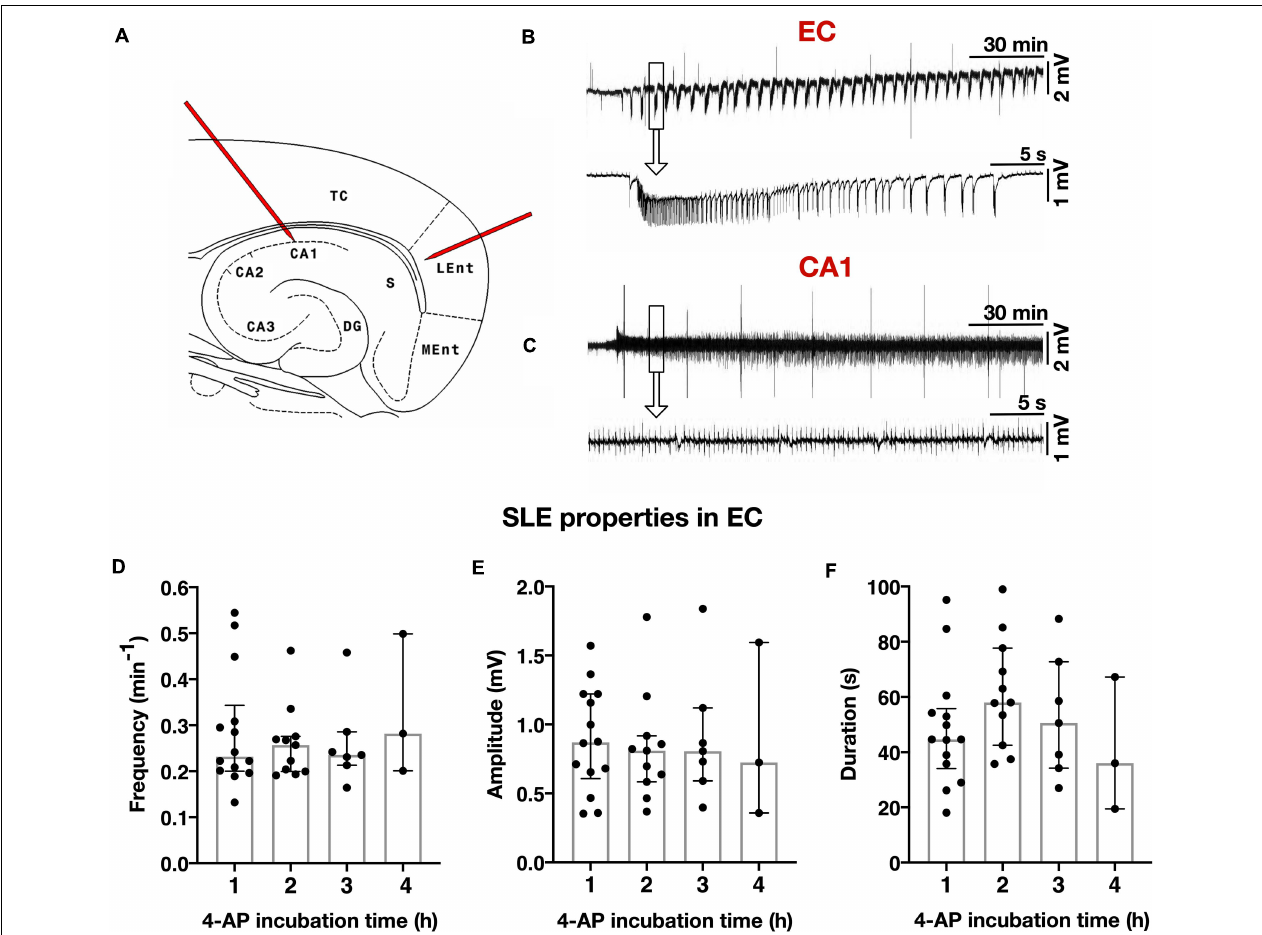
FIGURE 2 | Electrophysiological recordings in rat slices. (A) Schematic drawing of a combined hippocampal-entorhinal cortex slice with localization of two extracellular recording electrodes in layer IV/V of the lateral EC and stratum pyramidale of the hippocampal CA1 region, respectively. TC = temporal cortex, LEnt = lateral entorhinal cortex, MEnt = medial entorhinal cortex, S = subiculum, CA1–3 = hippocampal cornu ammonis, DG = dentate gyrus. (B) Exemplary trace of local field potentials in the EC during a 4 h experiment with stable occuring seizure-like events (SLEs). Single SLE marked in rectangle with enlarged presentation below. Monomorphic configuration of SLE with an initial sharp transient superimposed by a tonic and then clonic-like phase. (C) Representative recording of simultaneous interictal spikes in hippocampal CA1 during the same experimental period, enlarged depiction in the lower trace. (D–F) SLE properties in the EC remain stable as demonstrated by similar frequency (D) , amplitude (E) , and duration (F) for each treatment duration in a total number of n = 20 slices (five slices for each 4-AP treatment duration of 1, 2, 3, or 4 h). Scatter plots represent individual recordings for 4-AP treatment duration of 1–4 h, superimposed boxes show median ± interquartile